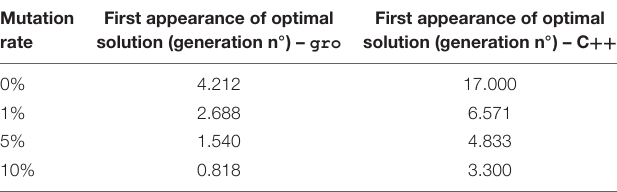
TABLE 3 | Mutation rate variation for SGA.